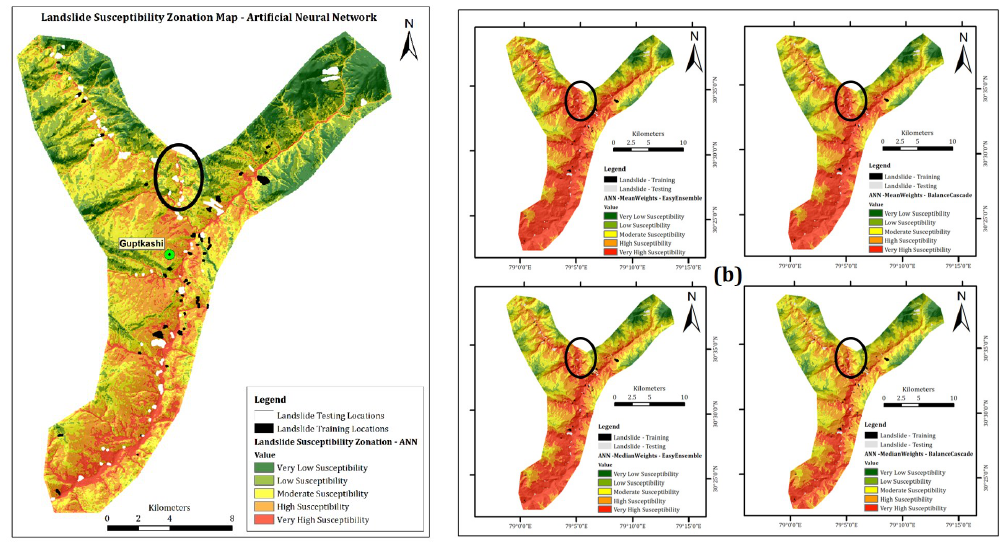
Figure 4. LSZ map obtained using weights from FDA, without data balancing (a) and with data balancing (b)